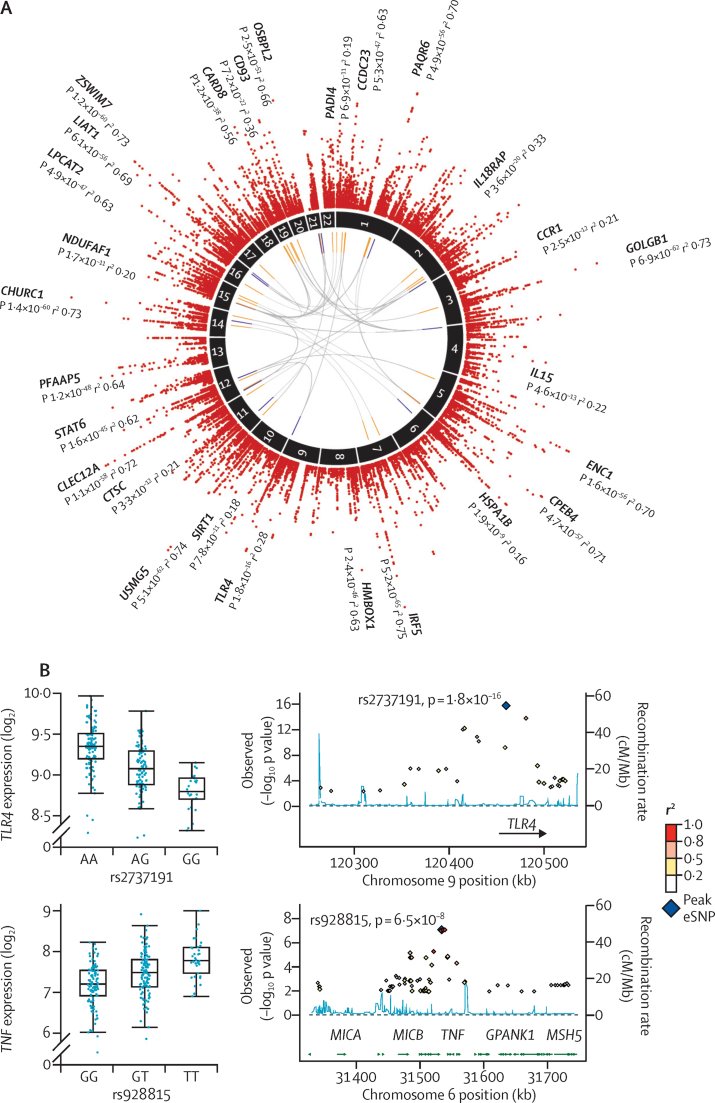
Sepsis eQTLCircos plot (A) of, from outer rim inwards, Manhattan plot for cis-eQTL in patients with sepsis (FDR <0·05) with names of genes with large effect sizes (variance explained, r2>70%) or examples of pathophysiological relevance shown; chromosome number; trans-eQTL (FDR<0·05) involving expression-associated SNPs also showing cis-eQTL (associated trans genes [orange] and SNPs [blue]). Box plots and local association plots for TLR4 and TNF (B). eQTL=expression quantitative trait loci. SNP=single-nucleotide polymorphism. FDR=false discovery rate.